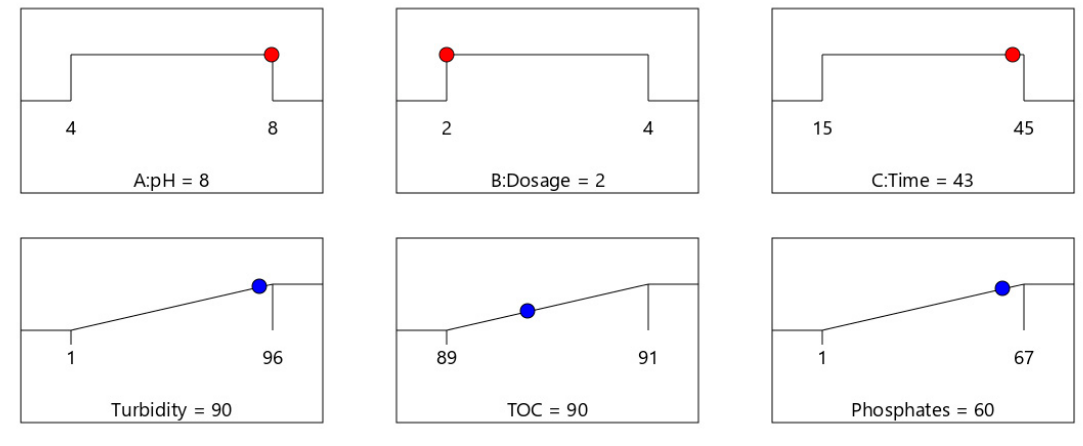
Figure 3. Ramp plot for numerical optimization conditions.